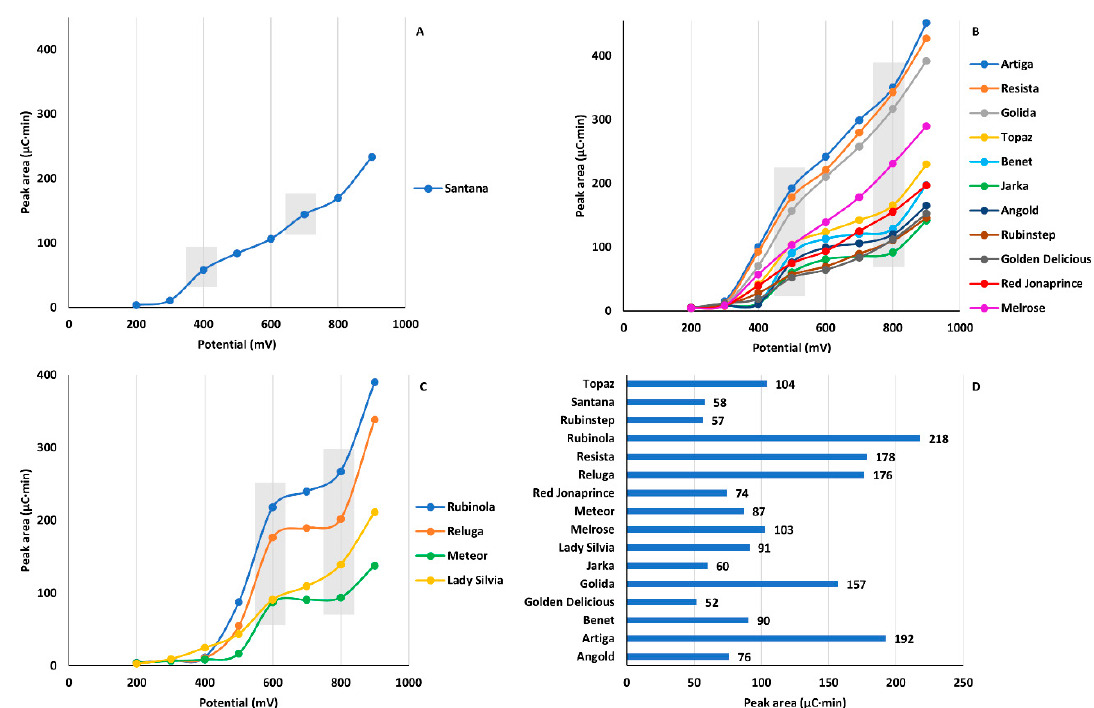
Figure 1. Evaluation of antioxidant activity using CD. Cumulative peak areas at each detection potential are plotted as a function of increasing detection potentials to a hydrodynamic voltammogram. Samples are divided by applied potential at which first inflection point (IP, meaning change of waveform direction) occurs, at 400 ( A ), 500 ( B ), and 600 mV ( C ). Comparison of samples based on sum of peak areas included in first electron transfer (IP 1) ( D ).